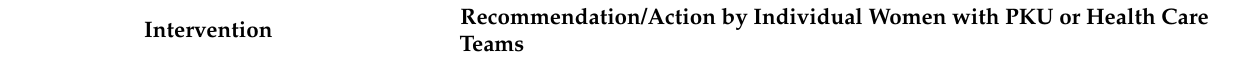
Table 1. Cont. Recommendation/Action by Individual Women with PKU or Health Care Intervention Teams Evaluate sleep patterns. Adults should aim to sleep at least 7 h per night to maintain optimal health [105]. Encourage good sleep hygiene Eating at late hours in the day has a negative effect on glucose, lipid, and energy metabolism [94], although a late-night dose of protein substitute may help decrease Phe